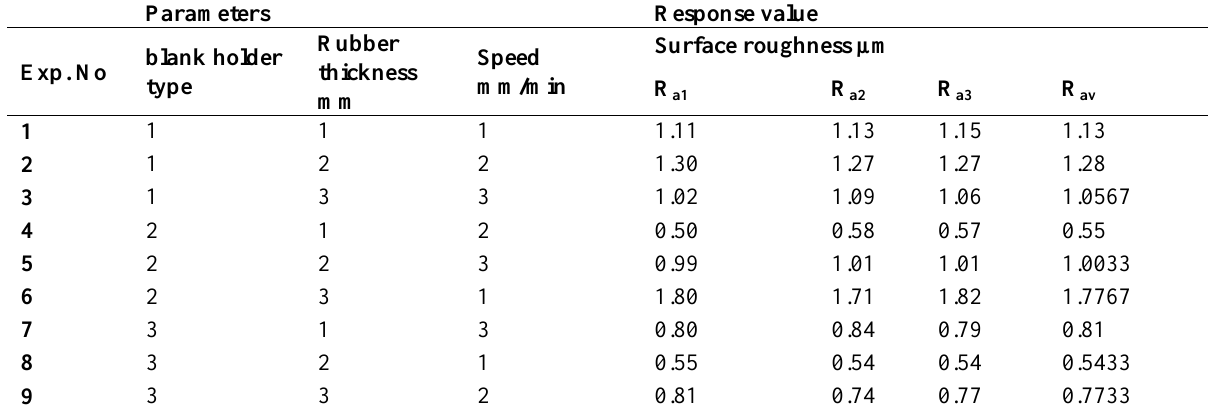
Taguchi’s L9 orthogonal array and response value